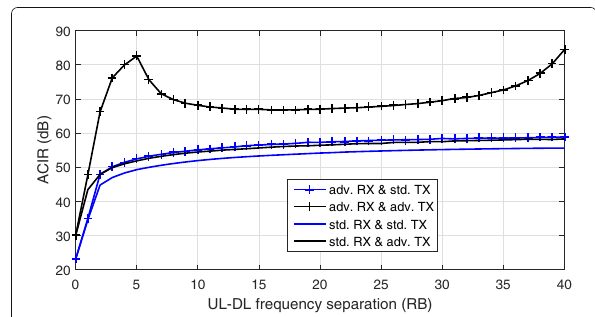
Fig. 7 Adjacent Channel Interference Ratio for a single PUCCH RB vs UL-DL frequency separation (0 RBs mean that PUCCH and PDSCH overlap) with standard and advanced